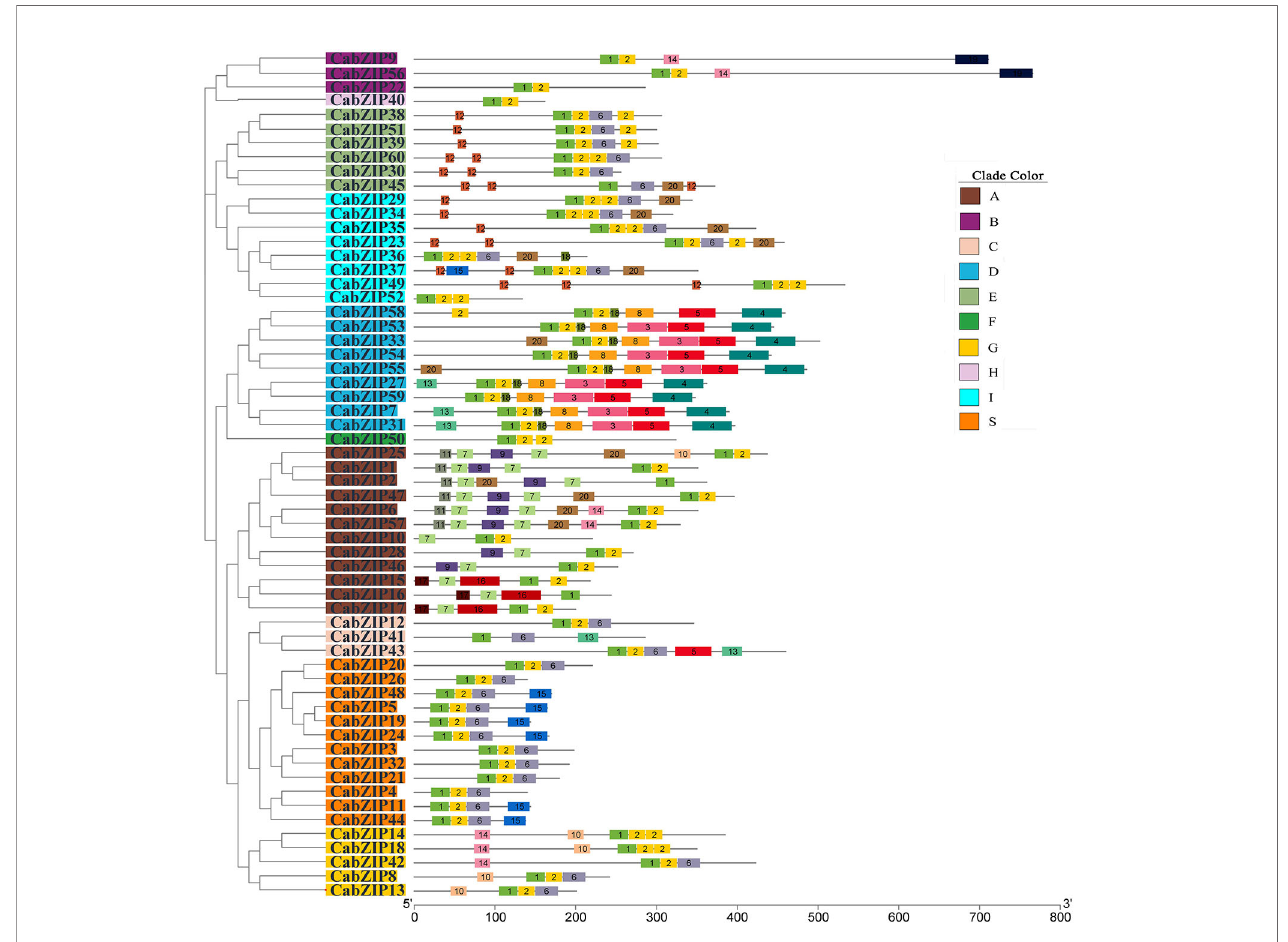
FIGURE 2 | Distribution of the conserved motifs identi fi ed in 60 CabZIP proteins. The protein structures of CabZIPs based on the predicted conserved motifs by MEME are given corresponding to the phylogenetic tree of the CabZIP proteins. The phylogenetic relationship and grouping are exactly the same as in Figure 1 . Each motif is represented by colored box with numbers 1 to 20. The details of conserved motifs are listed in Supplementary Table S3 and another sketch map of conserved motifs is shown in Supplementary Table S4